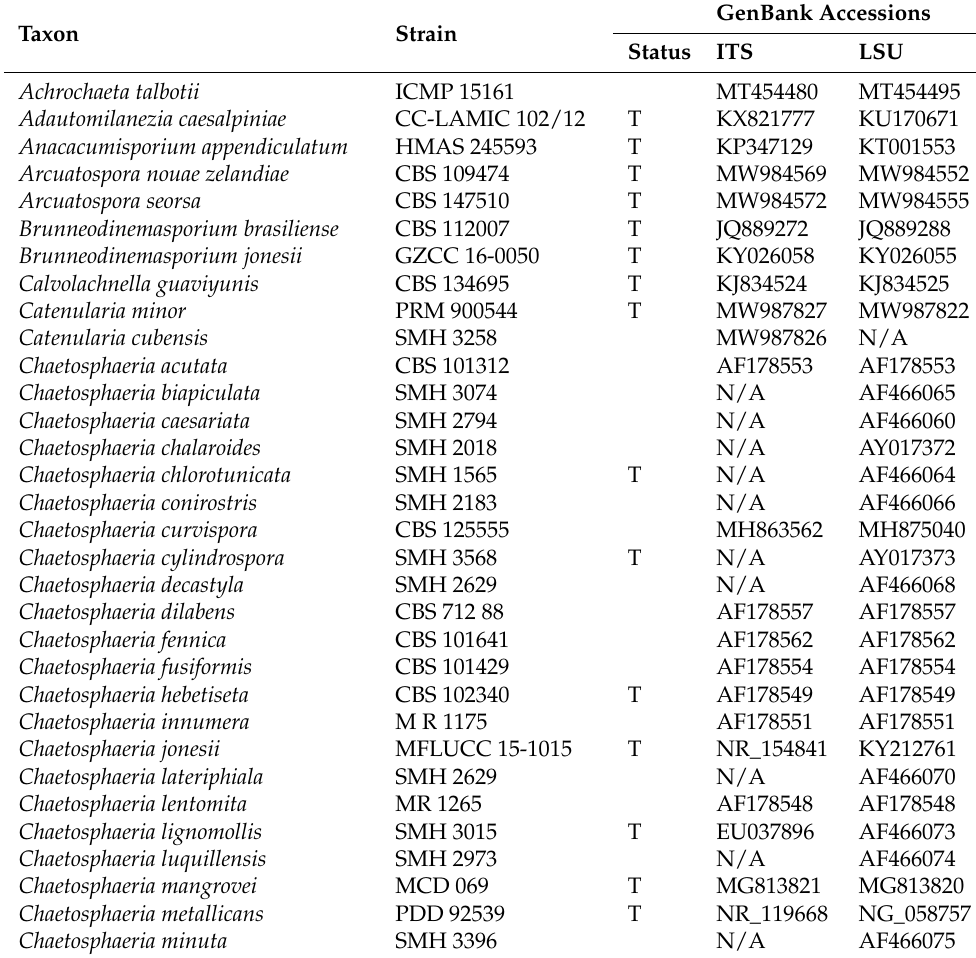
Table 2. Taxa used in this study and their GenBank accession